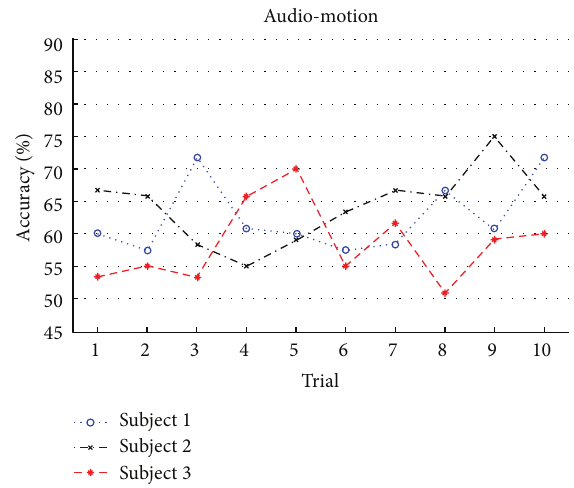
Figure 8: Classification accuracy of the audio and motion